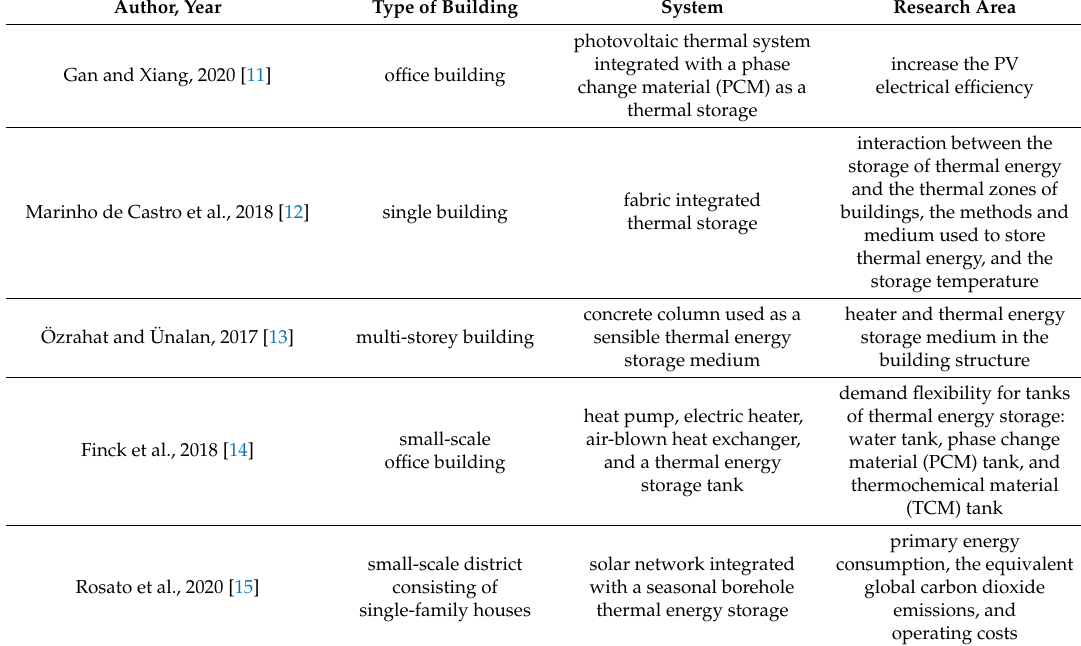
Table 1. Examples of thermal energy storage system analyses in the last three years.